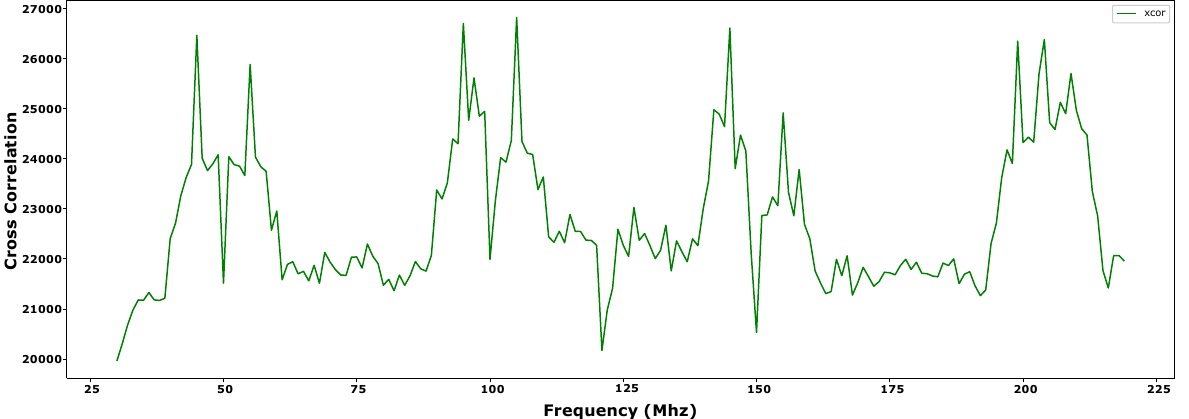
Figure 4. Cross-correlation for the two traffic patterns across the frequencies